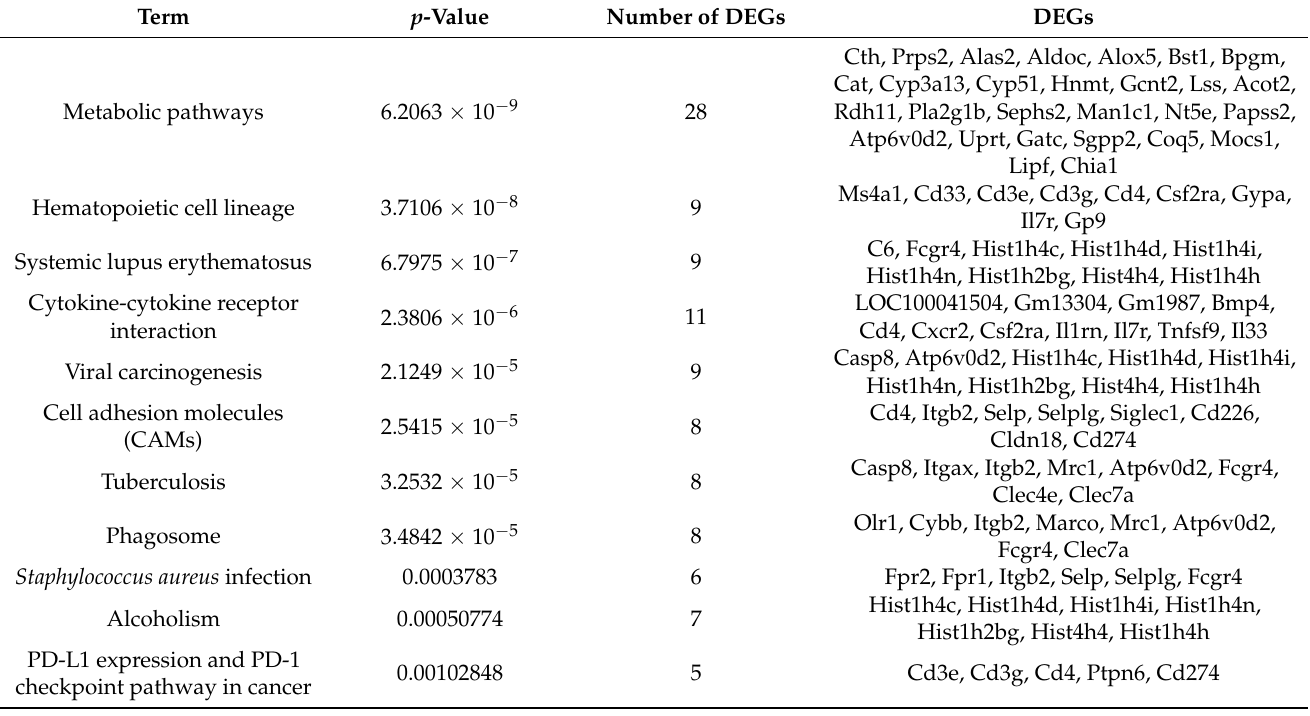
Table 1. Detailed analysis of Kyoto Encyclopedia of Genes and Genomes (KEGG)